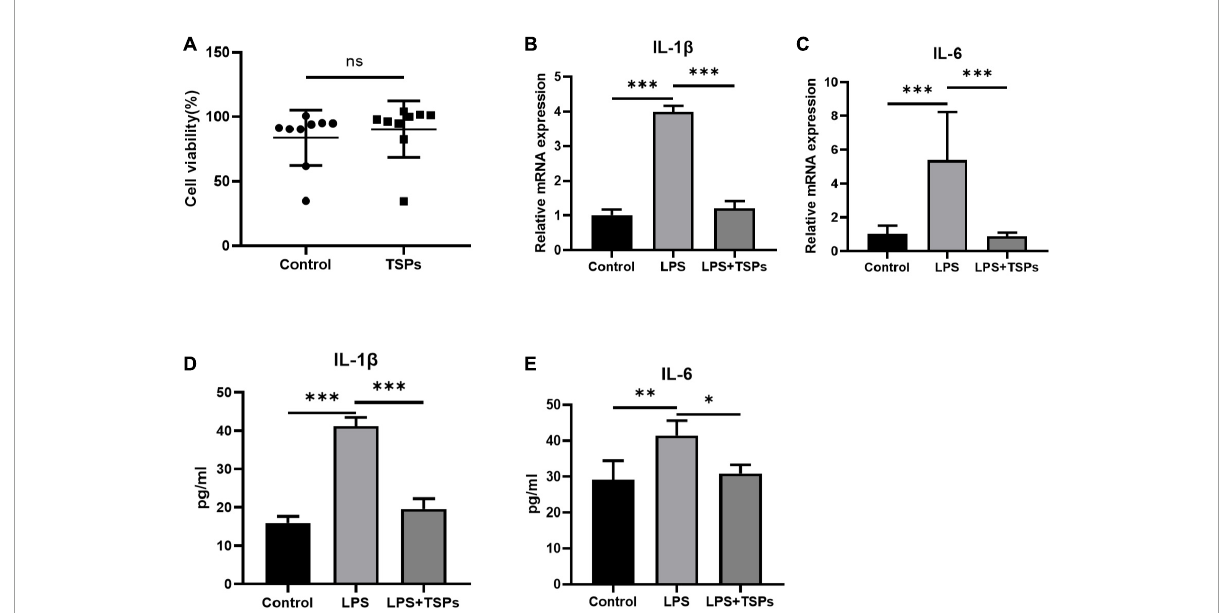
FIGURE3 The cell viability and expression of pro-inflammatory cytokines of human colonic epithelial cell line HT-29. (A) Cell viability was determined by CCK-8 assay after TSPs treatment ( n = 9). (B,C) Relative mRNA expression of two pro-inflammatory cytokines, IL-1 β and IL-6 ( n ≥ 3). The concentrations of IL-1 β (D) , IL-6 (E) measured by ELISA ( n = 6). Data were presented as means ± SD. Statistical significance was determined using Student’s t -test or one-way ANOVA. ∗ P < 0.05, ∗∗ P < 0.01, ∗∗∗ P < 0.001; ns, no